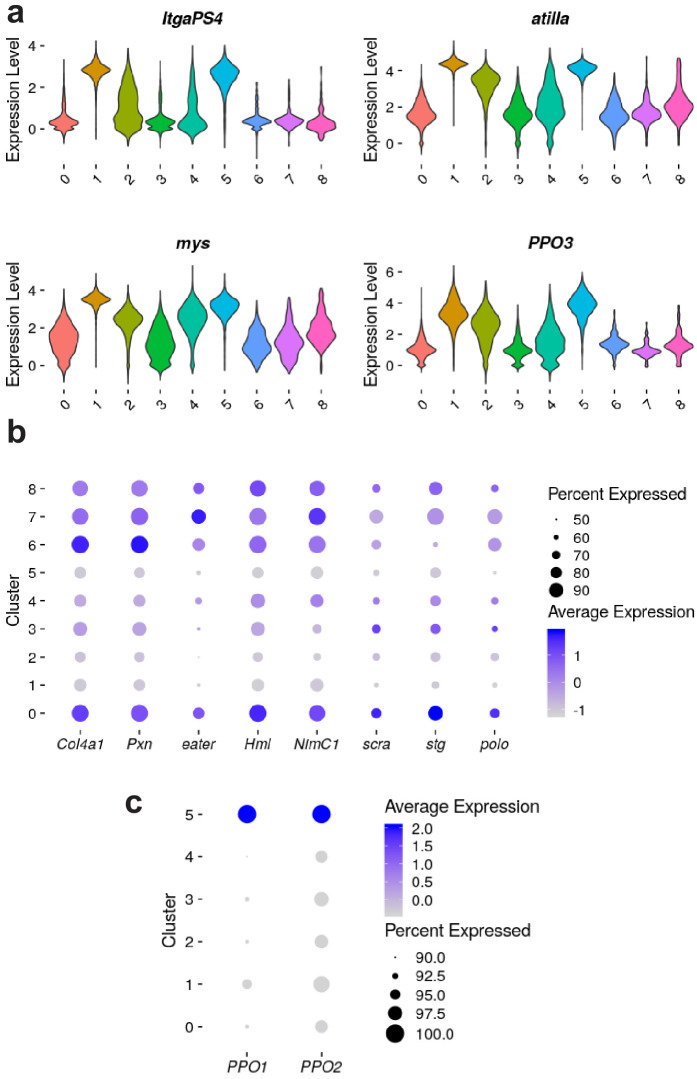
Expression levels (loge) of marker genes from early rounds of clustering.(A) Distribution of gene expression levels of described lamellocyte marker genes, for clusters identified from round three clustering. (B) Relative level of expression of described plasmatocyte and cell cycle marker genes, for clusters identified from round three clustering. (C) Relative level of expression of two known crystal cell markers from round one of subclustering, using lamellocytes and their plasmatocyte progenitors. Percent of cells expressing genes are indicated by circle size (B and C).